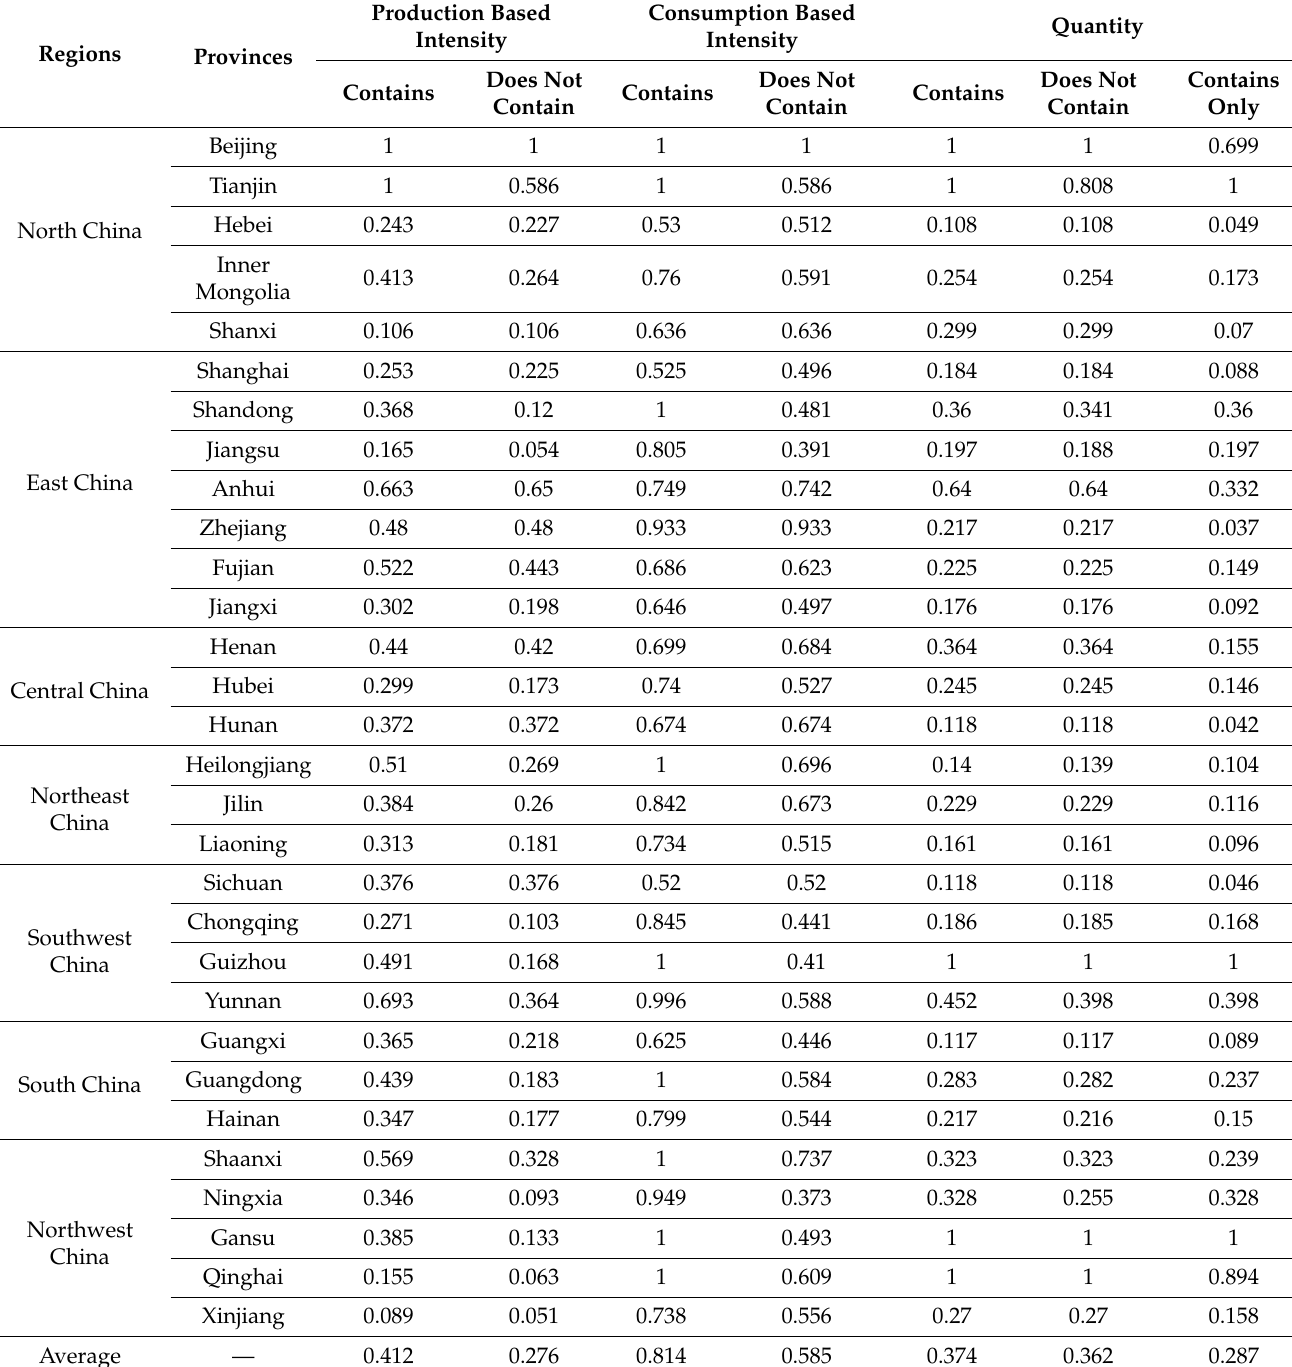
Table 2. Results of comprehensive input–output efficiency of the WEF